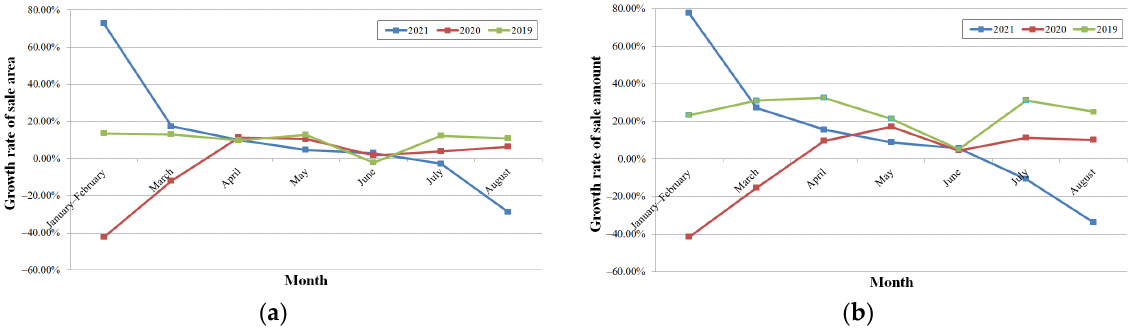
Figure 10. The YoY growth rate of commodity housing sales (data from Henan Province Bureau of Statistics): ( a ) the YoY growth rate of sale area; ( b ) the YoY growth rate of sale amount.